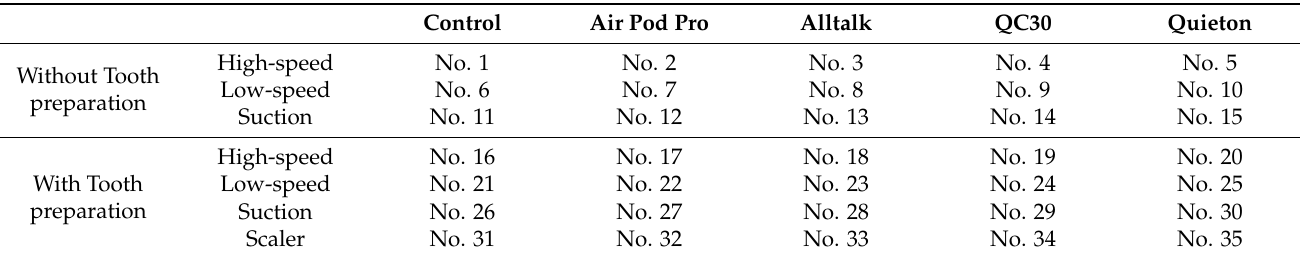
Table 1. Conditions of the recordings.